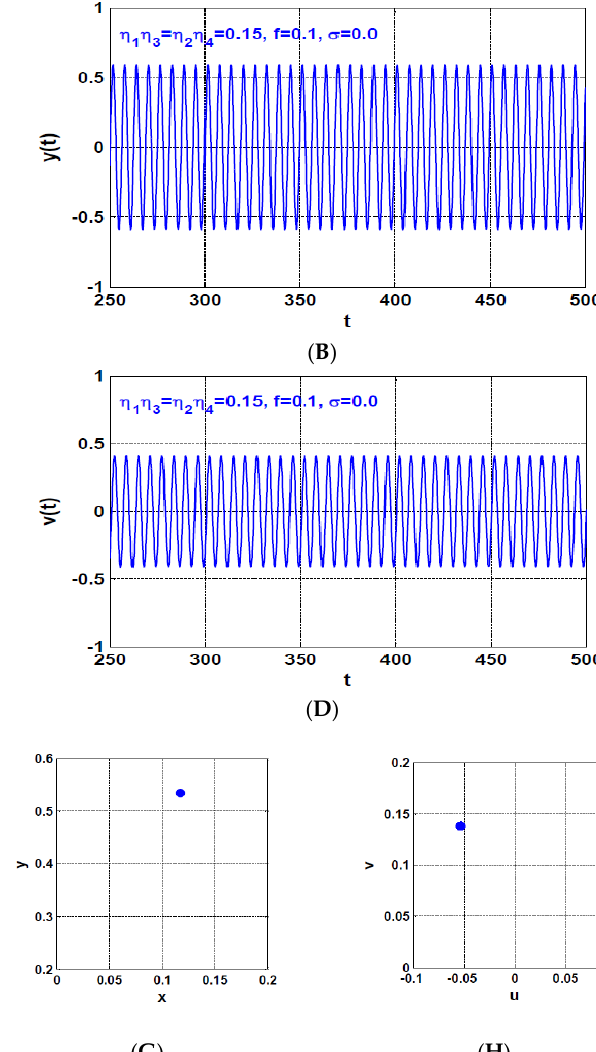
shown in Figure 21B 1